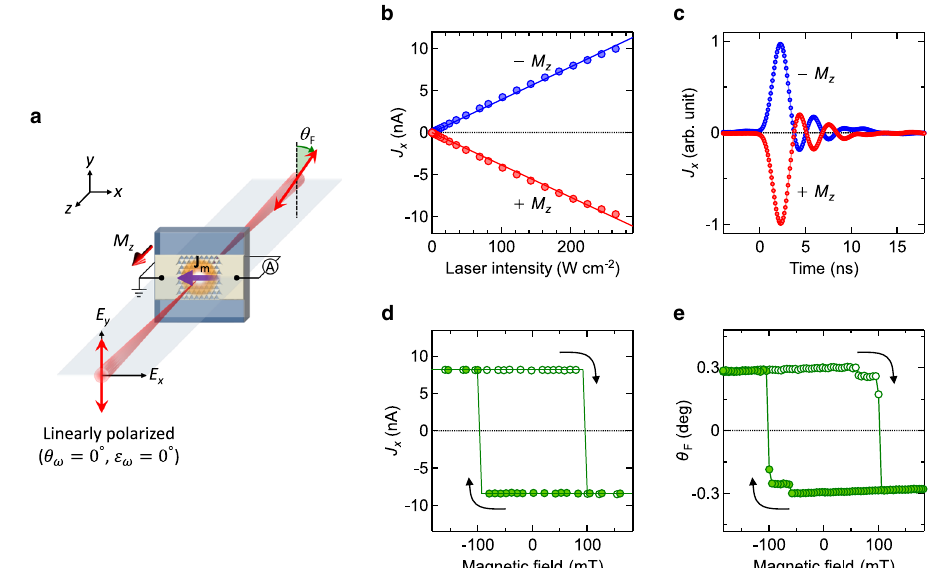
behaviorsin θ F arisefromtheexperimentalconditions:theincidentlaserbeamhits not only the MM but also slightly the surrounding unstructured Co/Pt multilayer fi lmwithasmallermagneticcoercive fi eldthanthatoftheMM(seeSupplementary Fig.2).Two-step behavioris notobserved in J x in( d ) because the unstructured Co/ Pt multilayer fi lm has a centrosymmetric structure and therefore does not con-